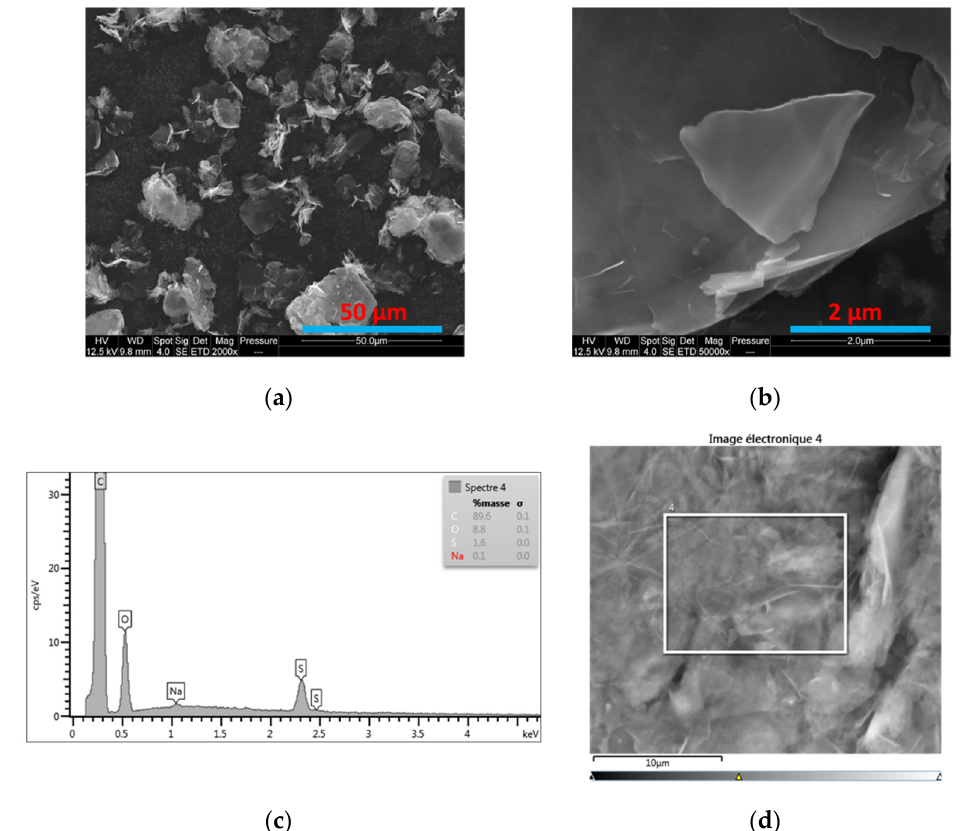
Figure 3. ( a , b ) SEM images of M5 GNP at different magnifications; ( c ) EDX graph; ( d ) the part of the surface that is surrounded by a rectangle and whose surface elements are shown in the EDX graph ( c ).